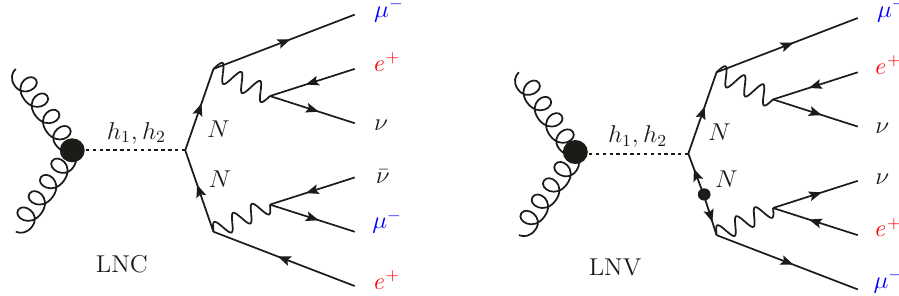
Figure 1 . Representative NN processes that contain two pairs of leptons of the same-sign and the same-(cid:13)avor. The LNC diagram (left) requires N couples to at least two lepton (cid:13)avors. where (cid:6) 2 W ( (cid:3)